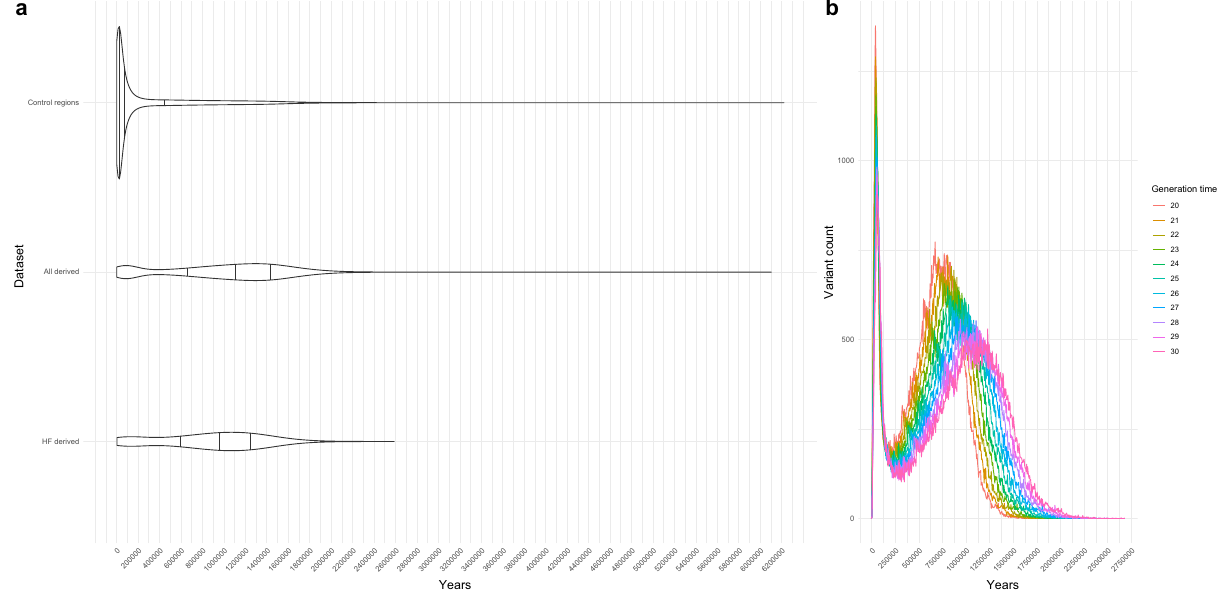
Figure 1. ( a ) Density of distribution of derived Homo sapiens alleles over time in an aggregated control set (n = 1000) of random variants across the genome and two sets of derived ones: all derived variants, and those found at high-frequency. Horizontal lines mark distribution quantiles 0.25, 0.5 and 0.75. ( b ) Line plot showing the bimodal distribution of high-frequency variants using different generation times (in the text, we used 29 years, following 62